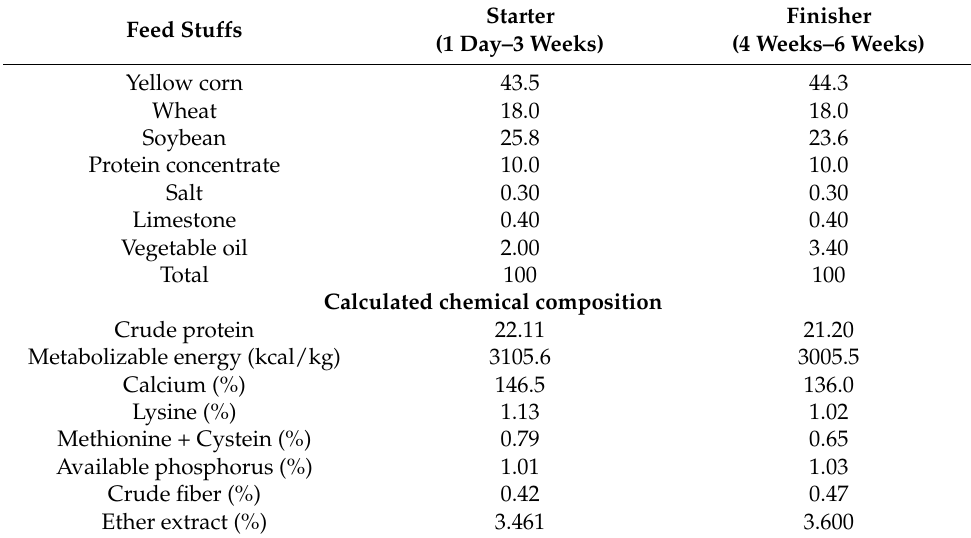
Table 1. The composition of birds’ diets.